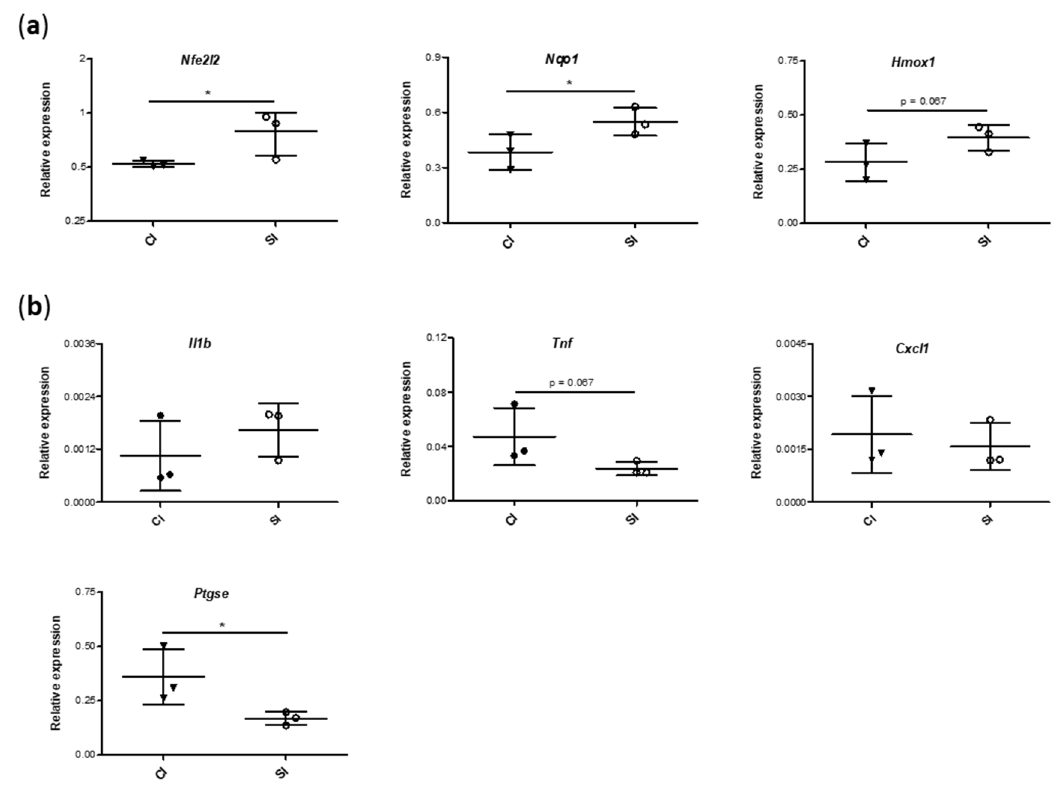
Figure 7. Measurement of the gene expression of antioxidant and pro-inflammatory markers. Relative expression levels of genes involved in antioxidant response ( a ) (nuclear factor erythroid-derived 2-like 2 ( Nfe2l2 ), nicotinamide adenine dinucleotide phosphate hydrogen (NADPH):quinone oxidoreductase ( Nqo1 ), and heme oxygenase-1 ( Hmox1 )) and in pro-inflammatory signaling ( b ) (interleukin-1β ( Il1b ), tumor necrosis factor-α ( Tnf ), cytokine-induced neutrophil chemoattractant-1 ( Cxcl1 ), cyclooxygenase 2 ( Ptgse )) were analyzed in blood samples from each group of the study, as previously indicated. Values are mean ± SEM ( n = 3 independent animals for each condition). # p ≤ 0.05 vs. the CI group. CI, control injection; SI, H 2 S donor injection.